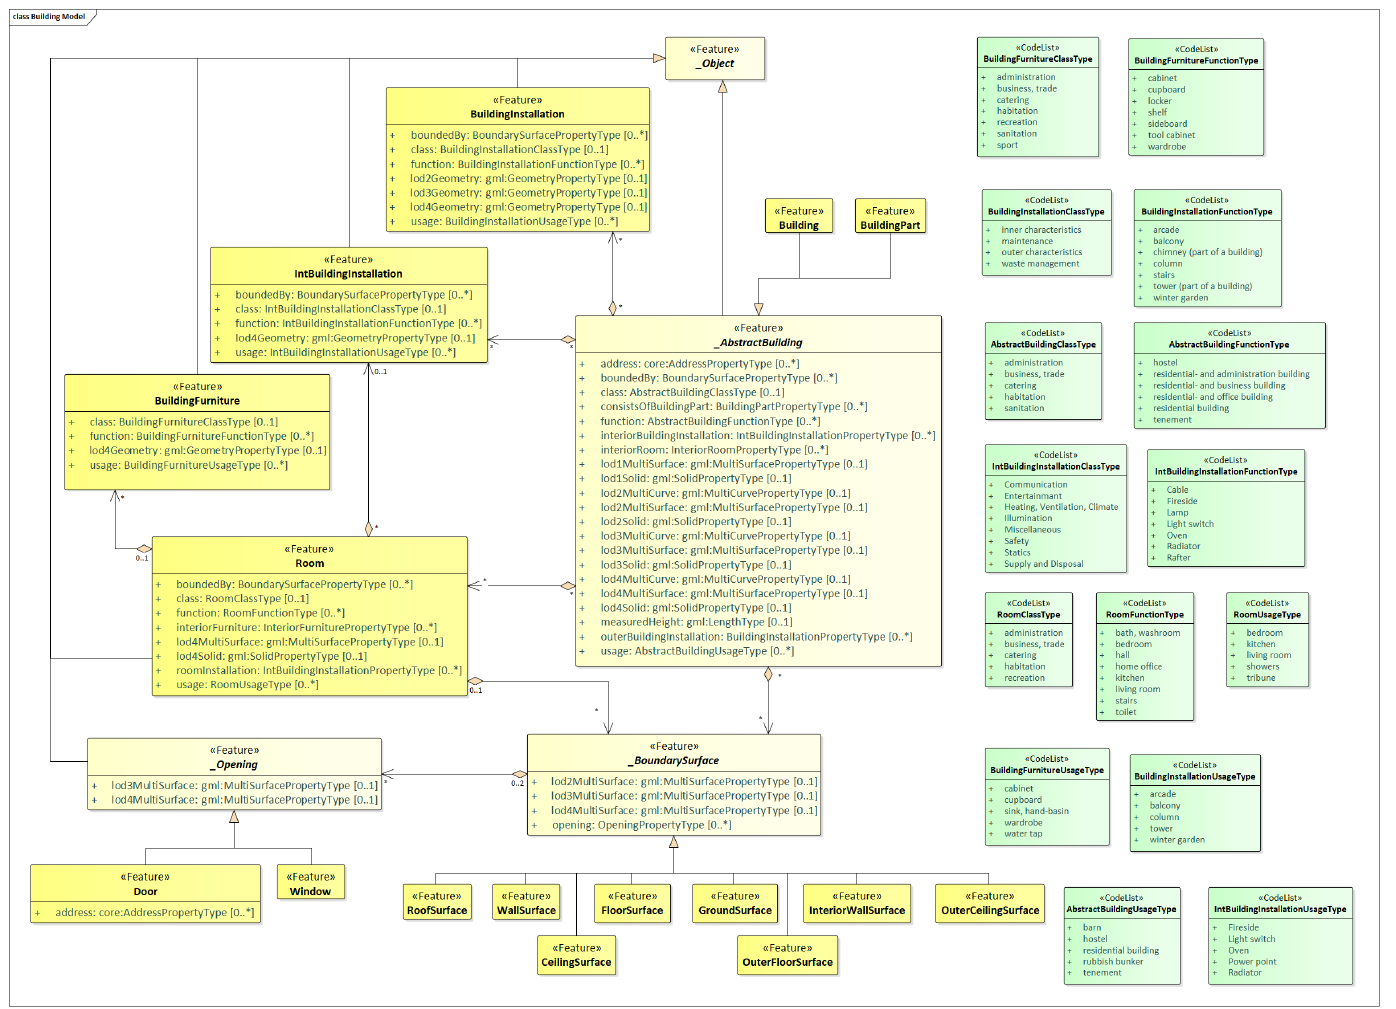
Figure A2. CityGML building